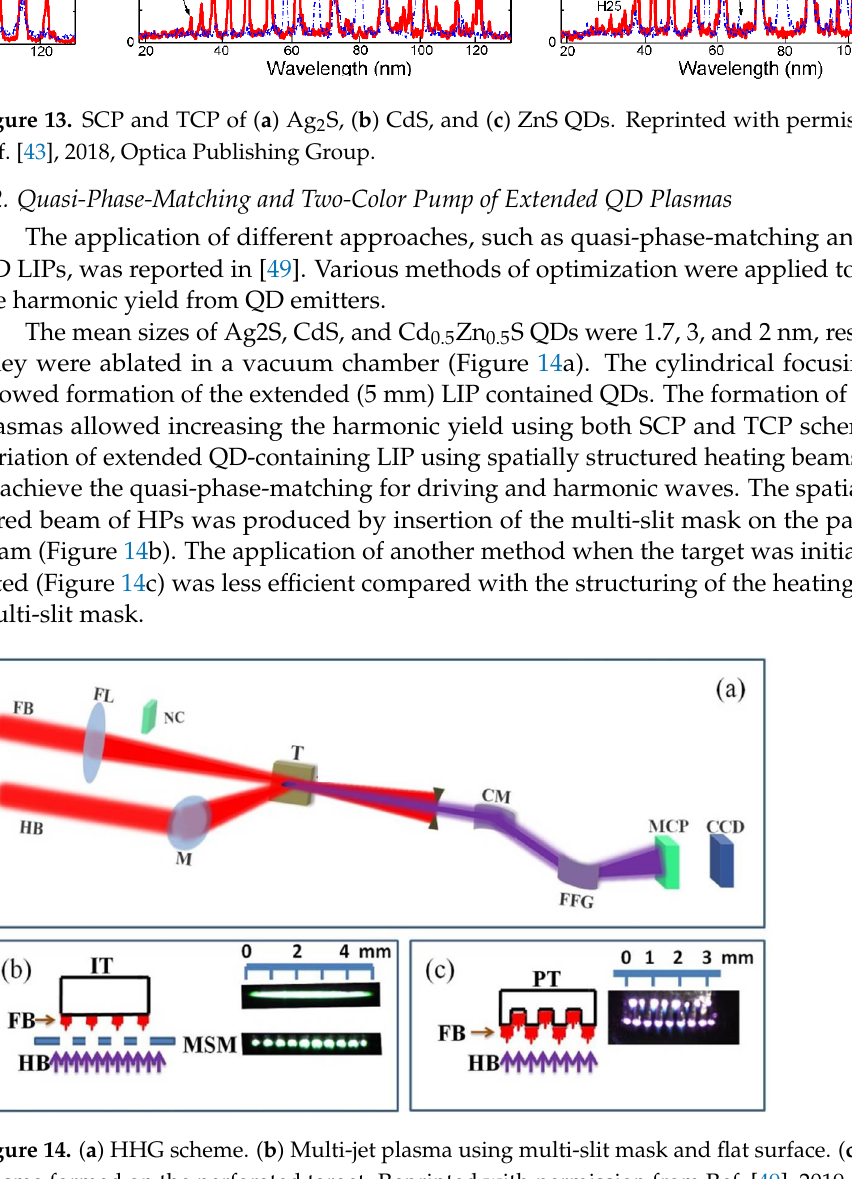
Figure 15. ( a ) HHG in Cd 0.5 Zn 0.5 S QD LIP. ( b ) HHG in CdS QD LIP. Reprinted with permission from Ref. [49], 2019, American Institute of Physics. The formation of quasi-phase-matching conditions between the driving and har- monic waves in QD LIP is shown in Figure 16. Previously, gaseous [50,51] and atomic plasma [52] media were used for the demonstration of this phenomenon. A division of an